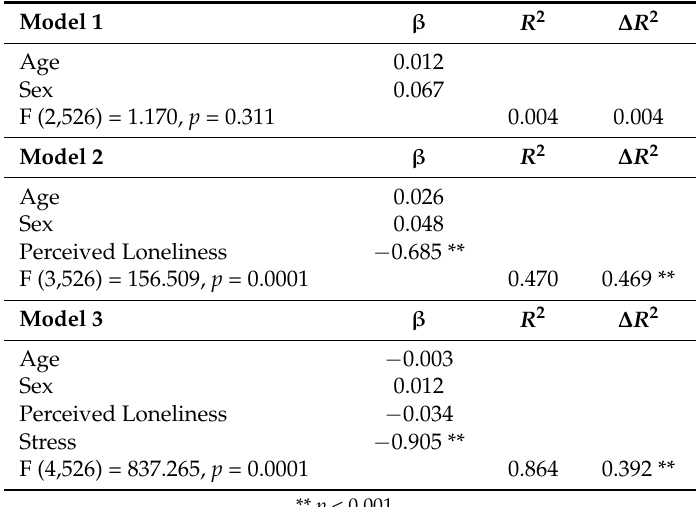
Table 4. Parameter estimates of age, sex, perceived loneliness, and stress as predictors of adherence to the MD.